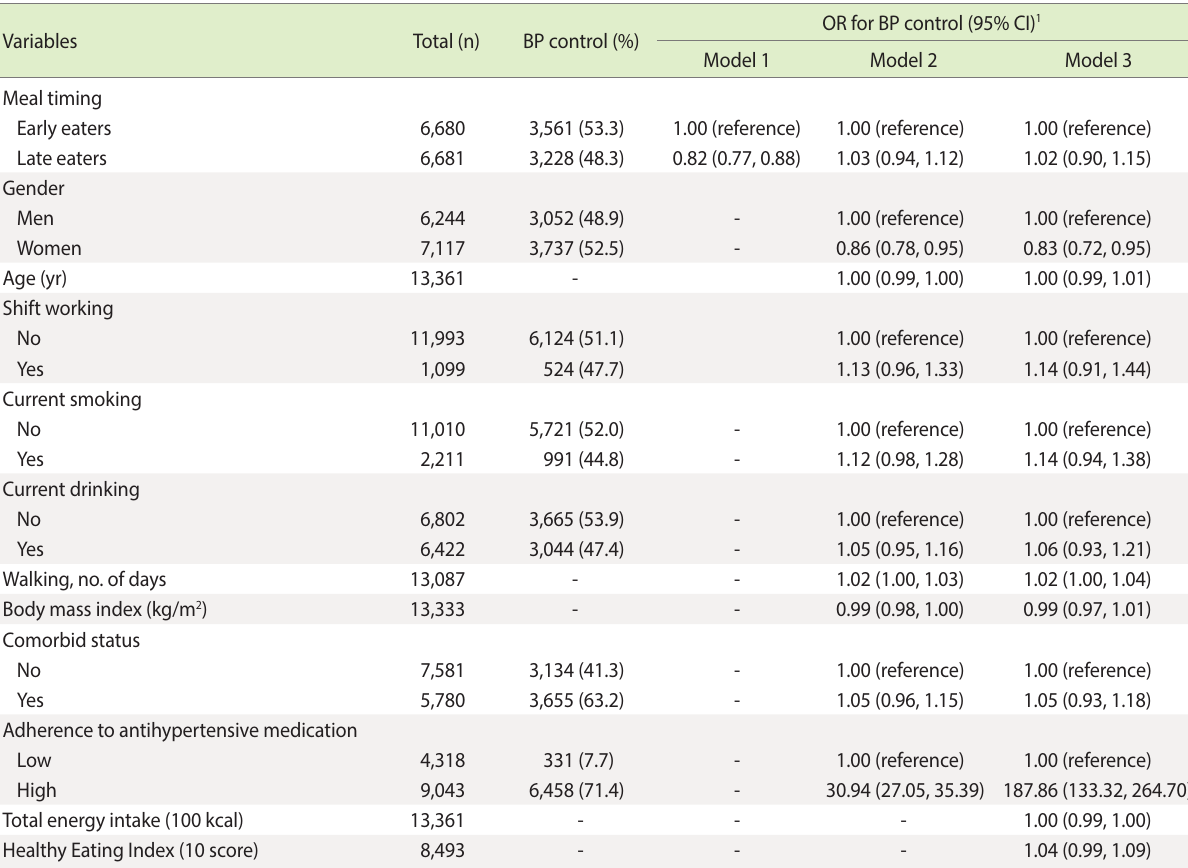
Table 3. Associations of late eating with blood pressure control in adults with hypertension